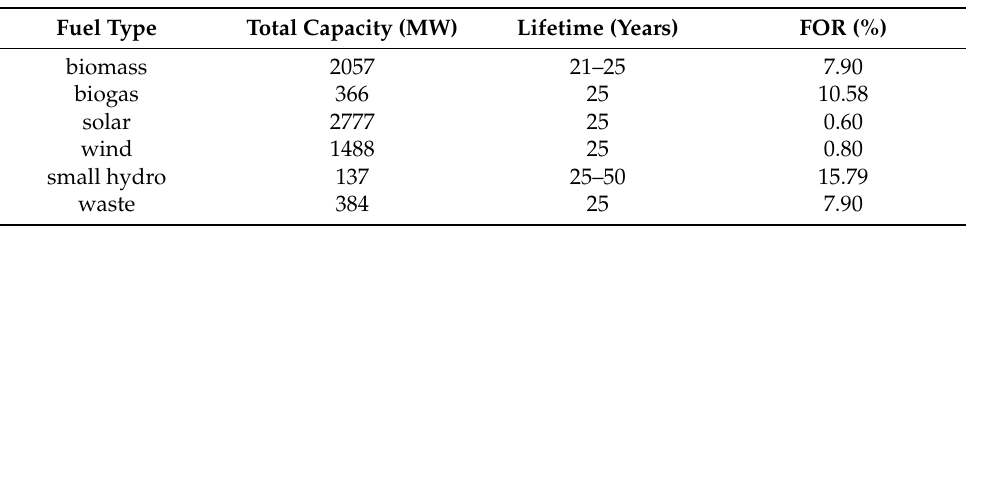
Table A4. Thailand’s renewable energy generation units as of December